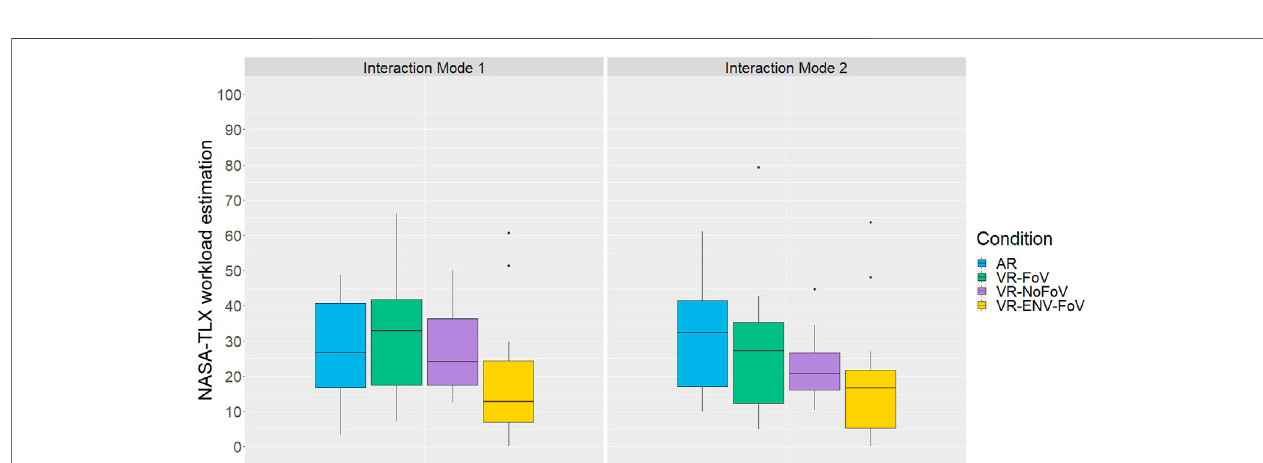
FIGURE 6 | Workload estimation based on NASA TLX for both interaction modes.